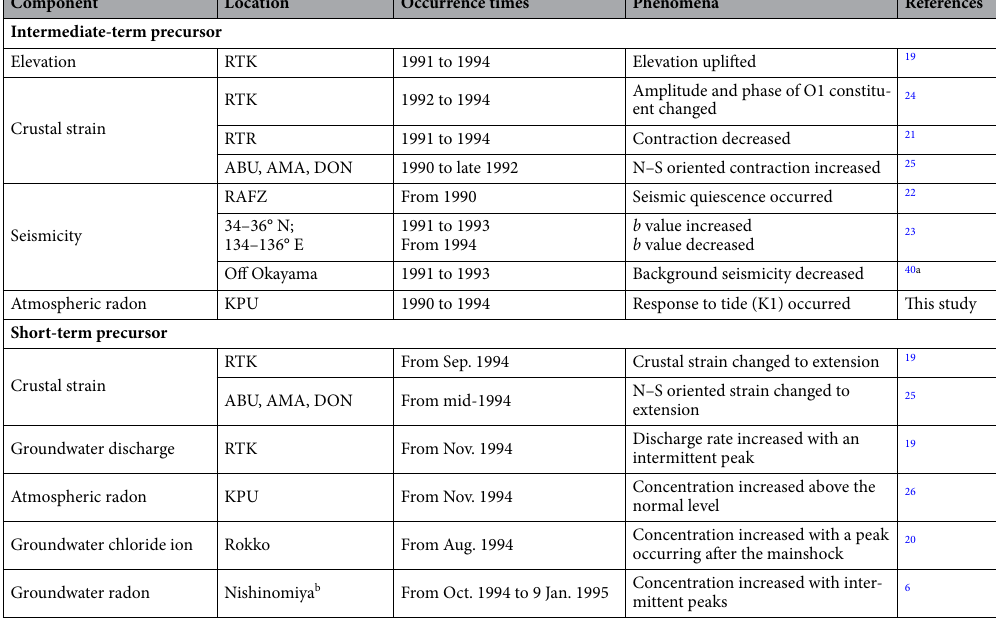
Table 1. Occurrence of geophysical, hydrological, and geochemical precursors before the Kobe earthquake (17 January 1995). a Ide and Tanaka 40 did not report the decrease in background seismicity as a precursor. b Nishinomiya is located 30 km northeast of the mainshock